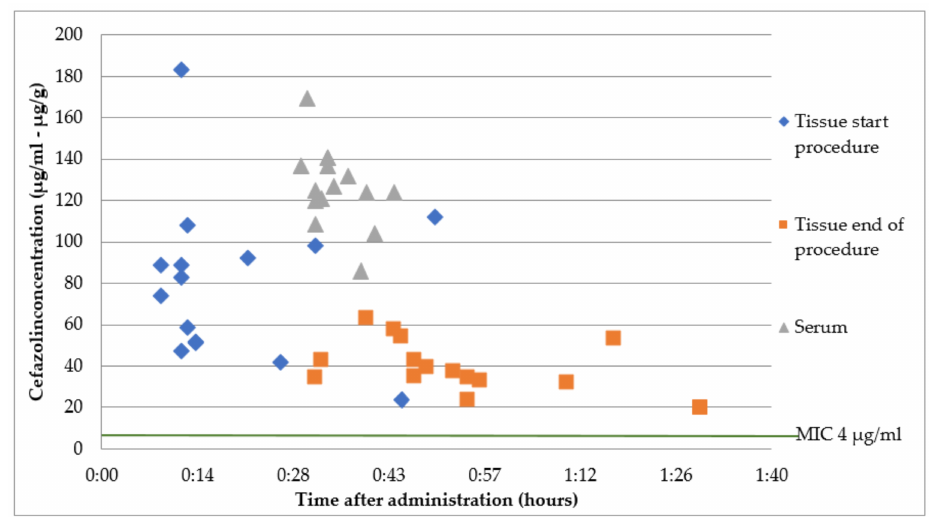
Figure 1. Cefazolin concentrations in serum and prostate tissue after a single intravenous dose immediately prior to surgery.